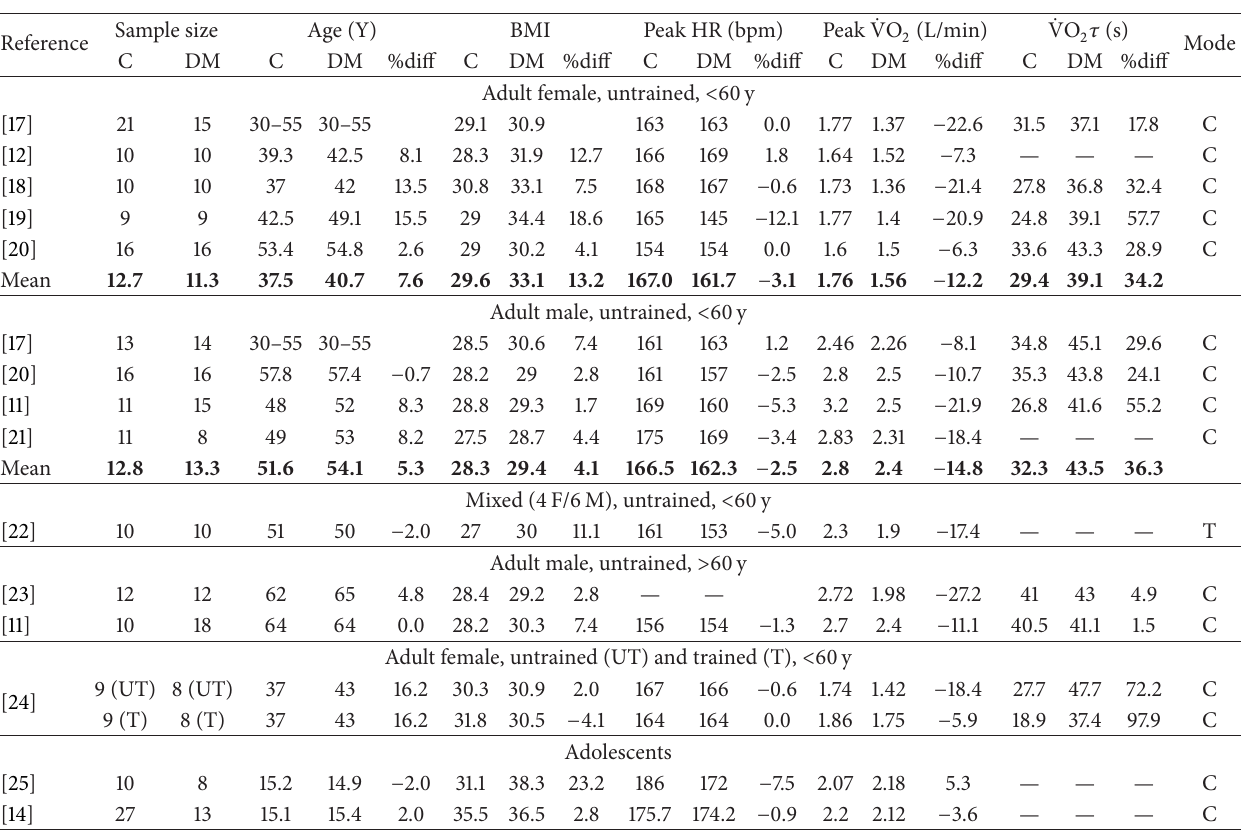
Table 1: Data from multiple studies pertaining to the effects of type 2 diabetes mellitus on peak heart rate (HR), peak oxygen uptake ( ̇ and the time constant of oxygen uptake ( VO 2 𝜏 ). Mean values are presented and the “Mean” corresponds to the average of the mean values from each study. “%diff” is the percentage difference between control and diabetic subjects. C = control subjects. DM = type 2 diabetes mellitus. “Mode” of exercise testing is cycling (C) or treadmill